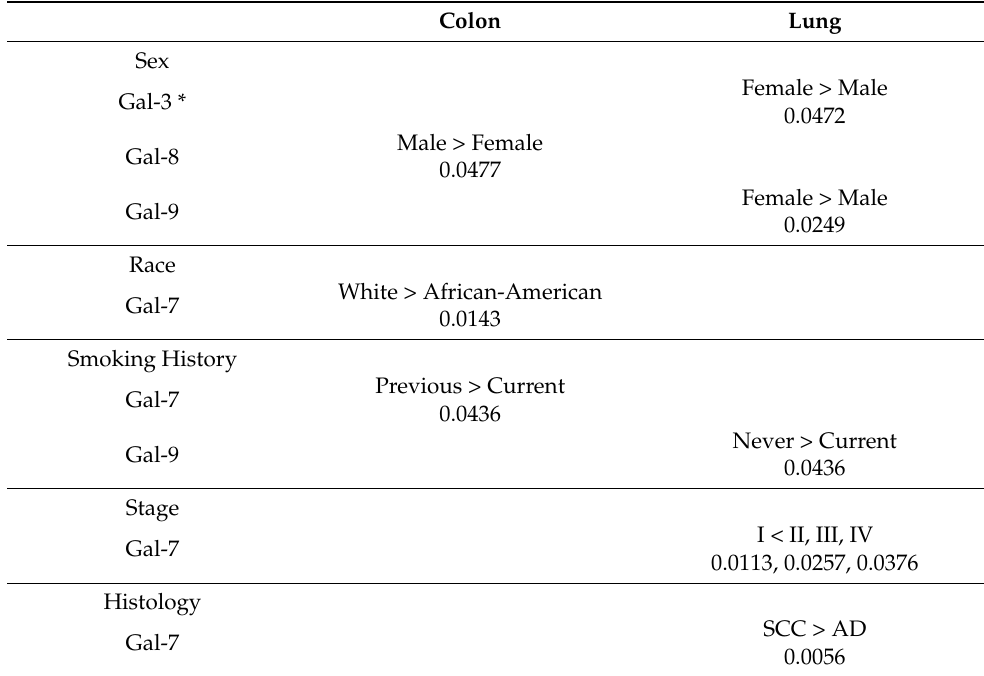
Table 1. Correlation analysis of galectin levels against cancer patient and tumor characteristics. Significant Wilcoxon p -values of one-way